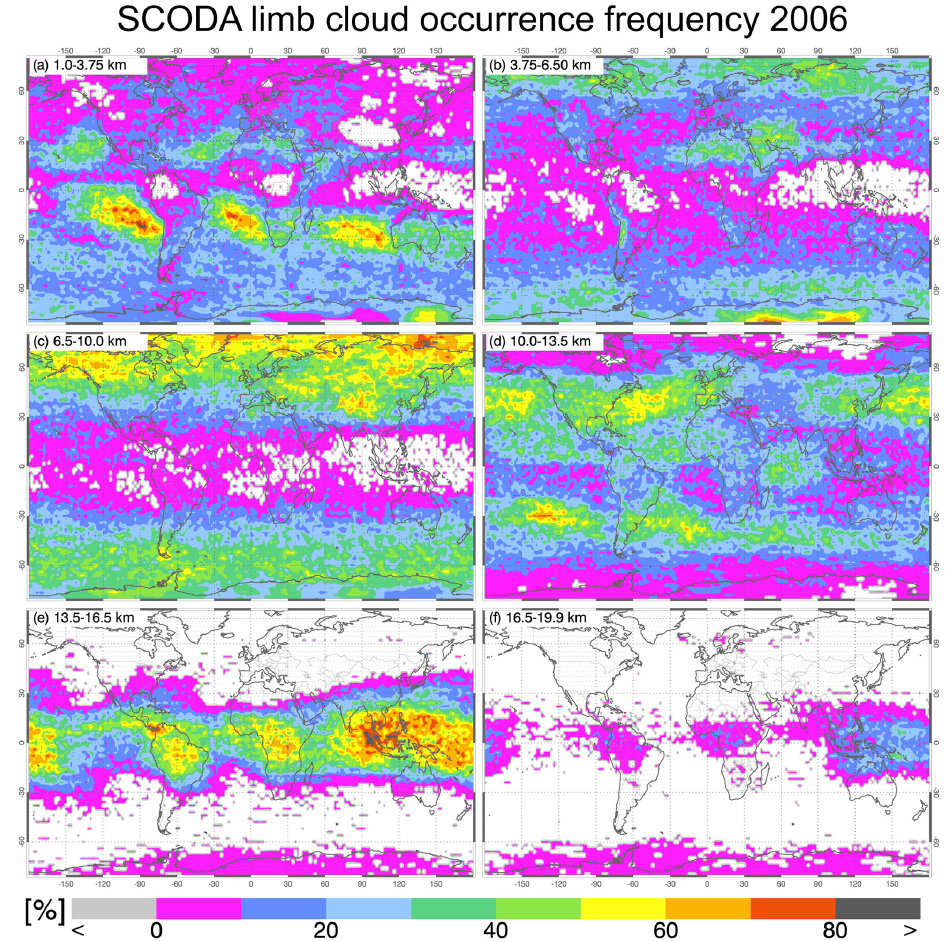
Figure 9. SCIAMACHY annual mean cloud occurrence frequencies for 2006 and for tangent heights between (a) 1.0 and 3.75km, (b) 3.75 and 6.5km, (c) 6.5 and 10.0km, (d) 10.0 and 13.5km, (e) 13.5 and 16.5km, and (f) 16.5 and